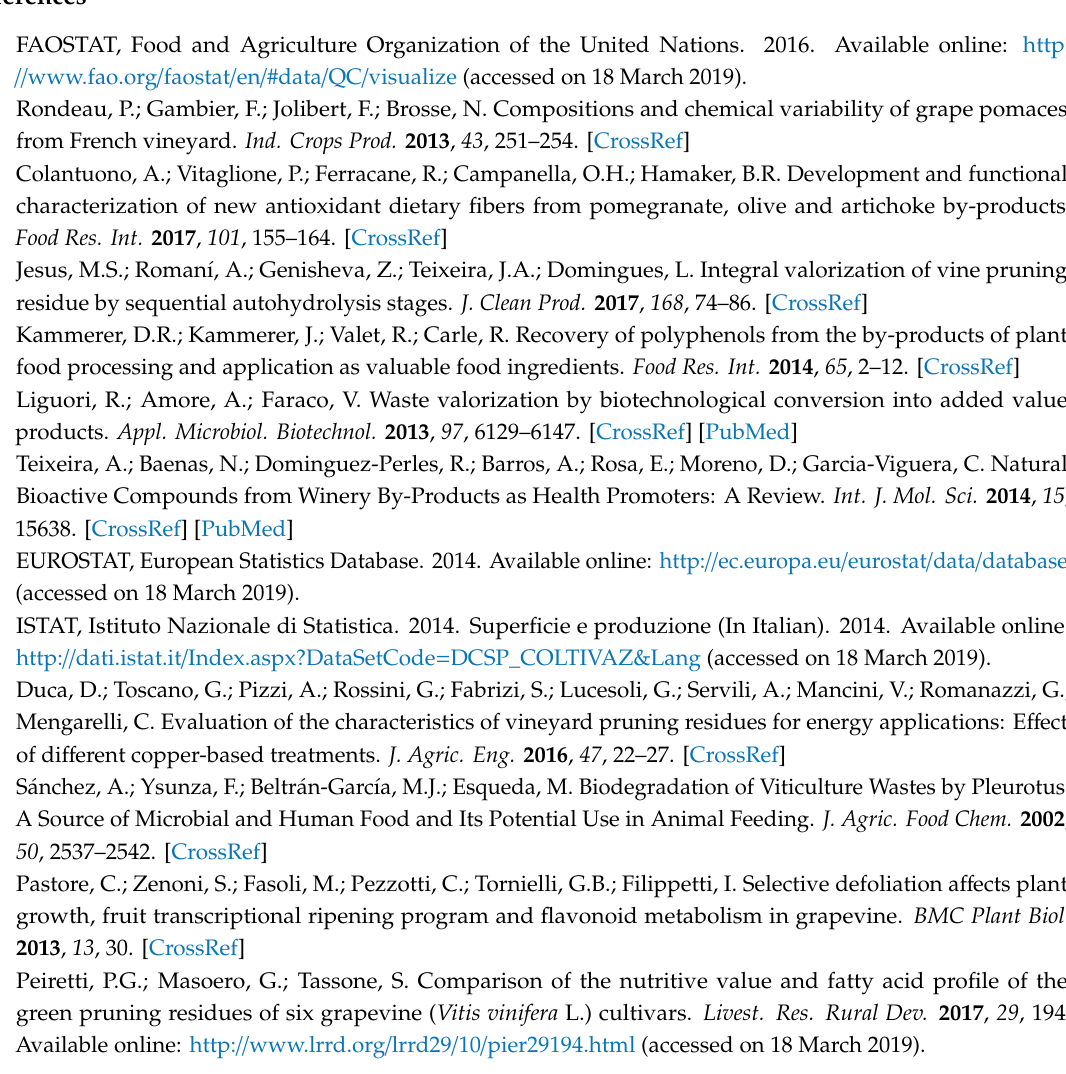
Supplementary Materials: The following are available online, Figure S1: Results of the optimization of extraction conditions obtained by experimental design relative to the sum of the peak areas; Figure S2: Results of the optimization of the extraction conditions obtained by the experimental design relative to the main components of the extracts; Figure S3: Box plots and histograms relative to the Folin–Ciocalteu assay; Figure S4: Box plots relative to the HPLC-PDA quantitative results on the main components of grapevine GPRs and leaves; Figure S5: Histograms relative to the in vitro colorimetric antioxidant assays for all GPRs and leaves extracts; Table S1: Variables, levels, and the design matrices evaluated in the two experimental design; Table S2: Pearson’s correlation matrix between HPLC-DAD quantitation results (in terms of sum of the concentrations of the main phenolics) and in vitro colorimetric antioxidant assays results; Table S3: List of the analyzed samples with their acronyms and sampling year; Table S4: Wavelengths, calibration ranges, equations of the curves and linearity of the target compounds used for